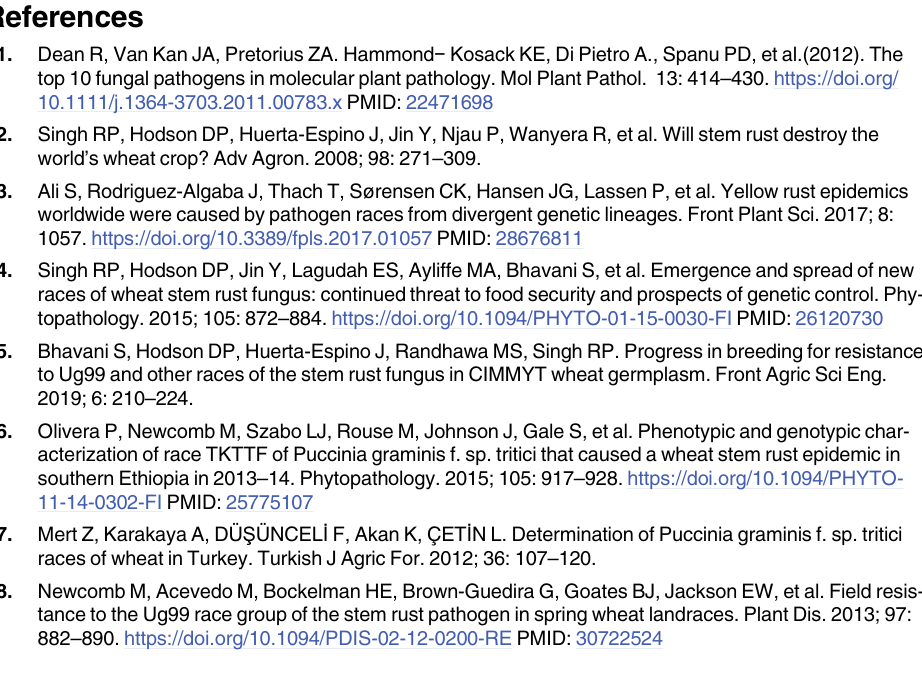
S5 Table. Accessions identified with different YR QTL combinations in Toluca environ- ment for future validation studies. S6 Table. Accessions identified with different SR QTL combinations in Kenya for future validation